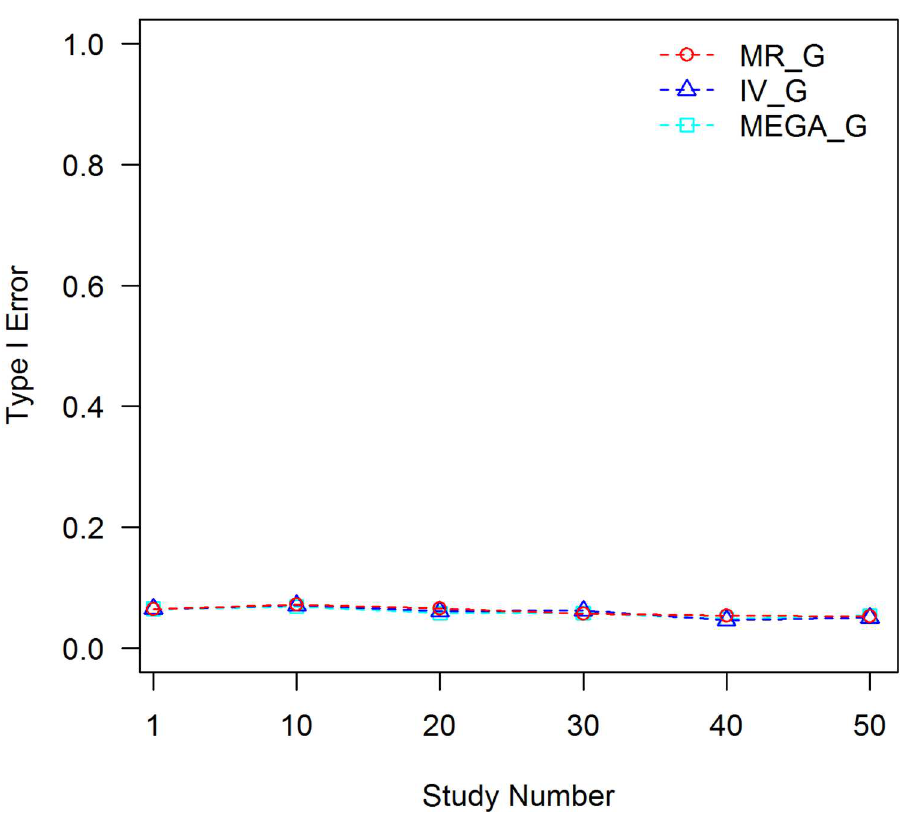
Fig 4. Tests of genetic main effect without controlling for the C × E confounder, f 1 = 0.3, f 2 = 0.1. MR_G: MR test of the geneticmain effect; IV_G: inversevariancetest of the genetic main effect; and MEGA_G: mega-analysis test of the genetic main